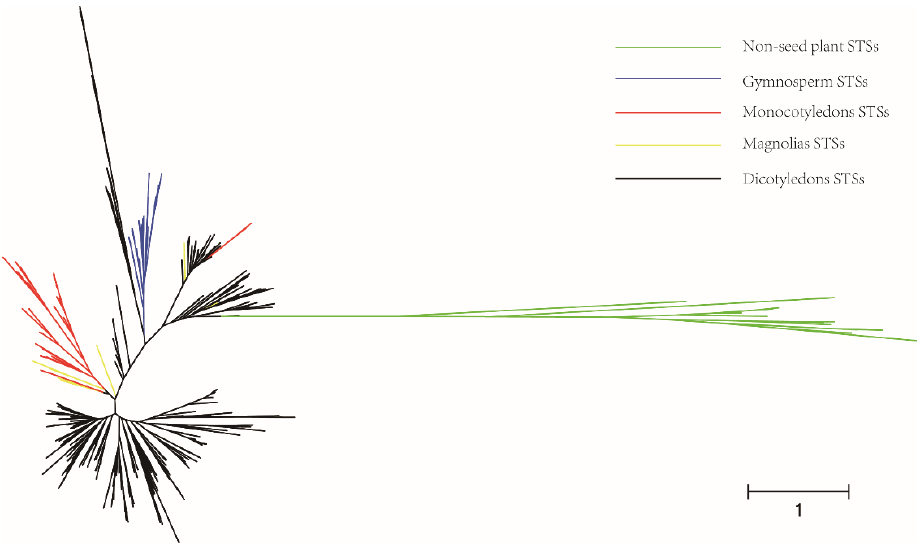
Figure 2. Phylogeny of functional plant STSs. Green clades represent non-seed plant STSs, blue clades represent gymnosperm STSs, red clades represent monocotyledon STSs, yellow clades represent magnolias STSs, and black clades represent dicotyledon STSs.